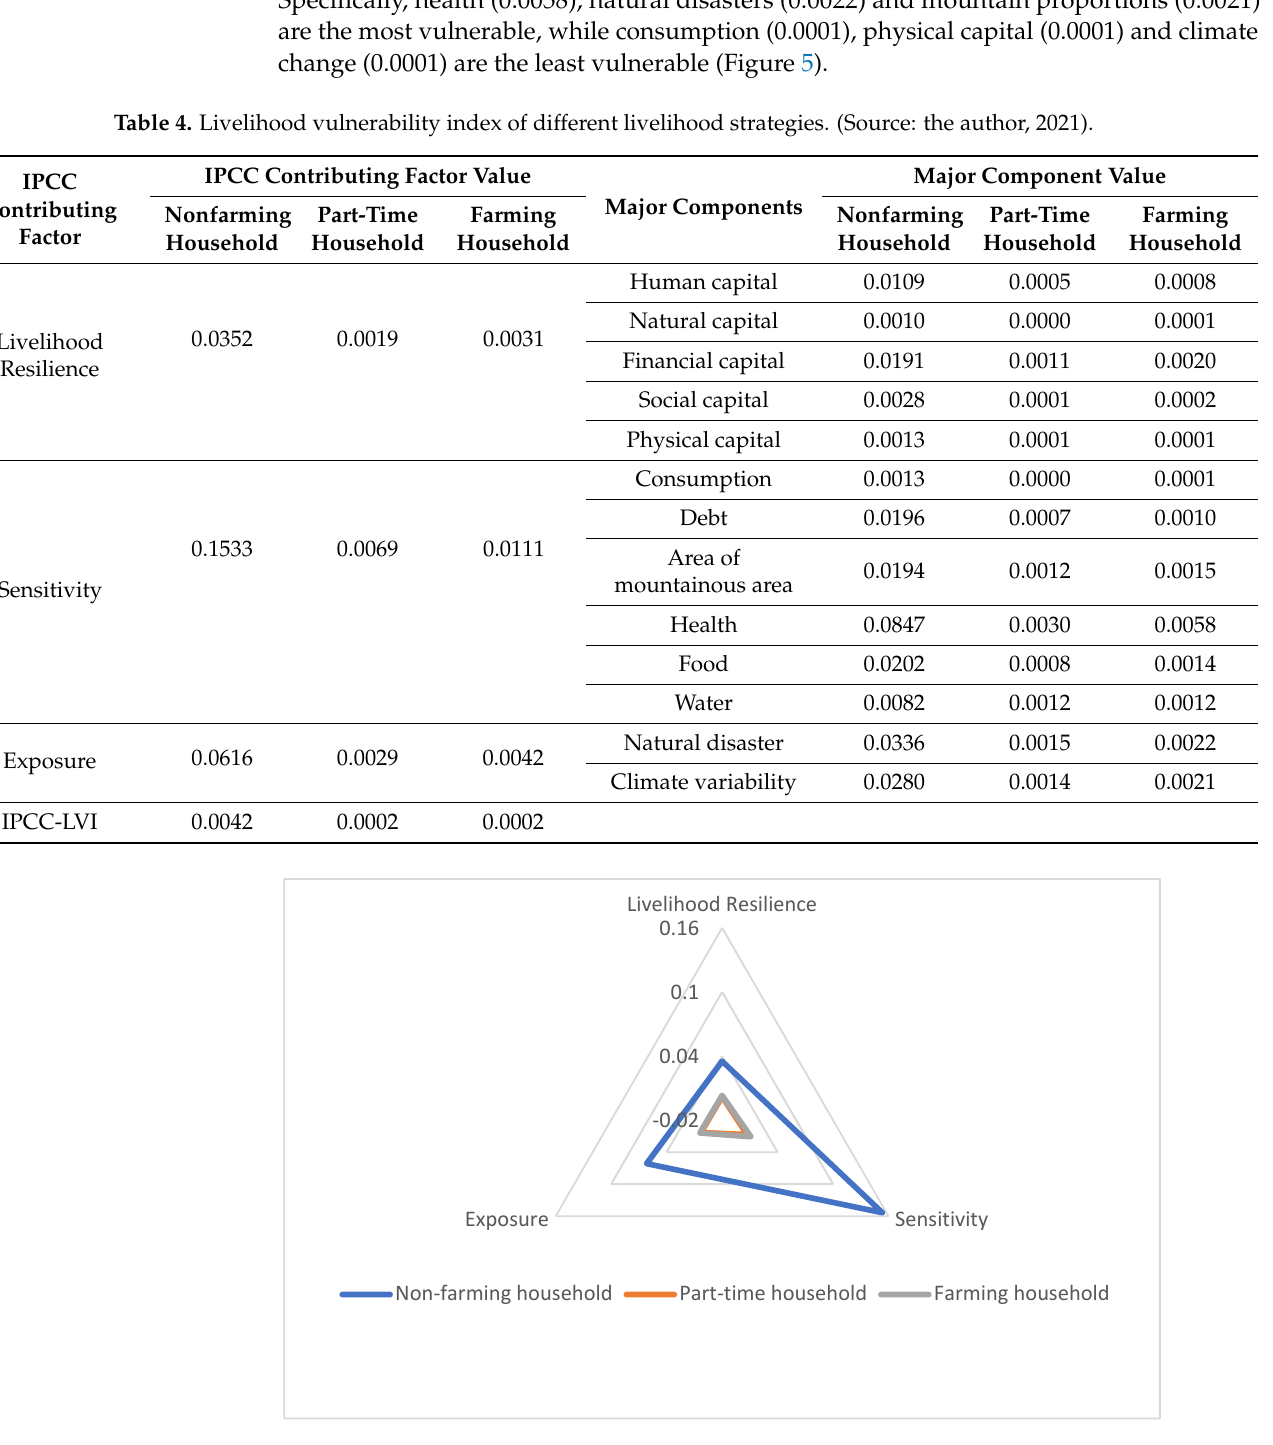
Table 4. Livelihood vulnerability index of different livelihood strategies. (Source: the author, 2021).